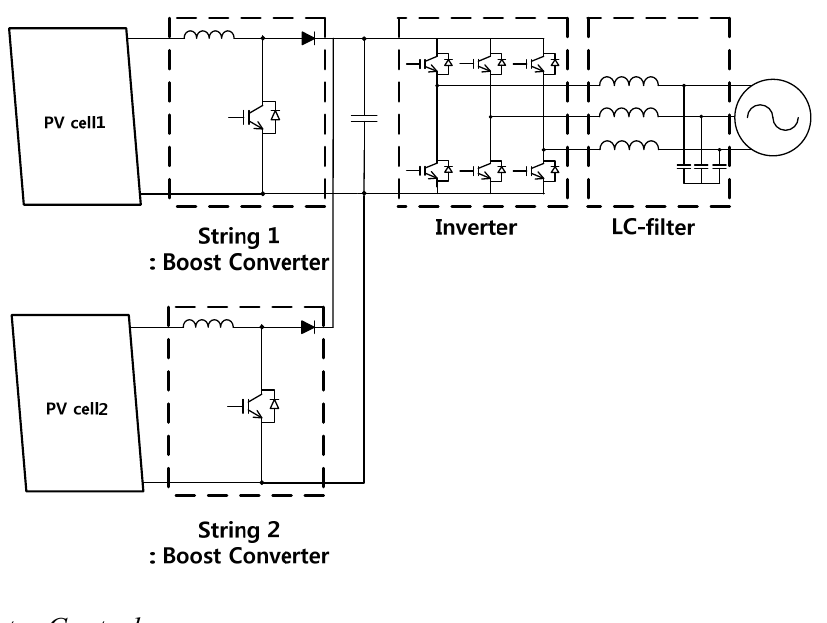
Figure 1. The configuration of a two-string PV